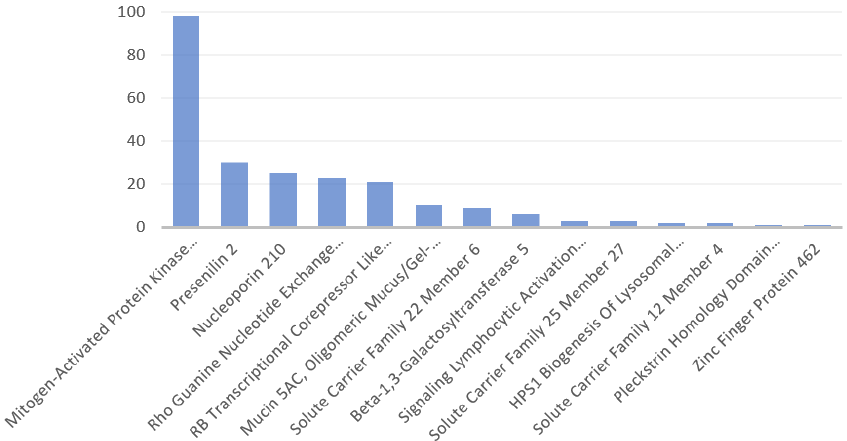
Figure 4. Number of associated superpathways of the identified human proteins in descending order. Mitogen activated protein kinase kinase 3 is outstanding with the highest number of associated superpathways, compared to the other proteins with the respective data (Appendix A, Table A2).